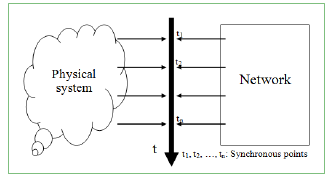
Figure 4. Synchronouspointsin